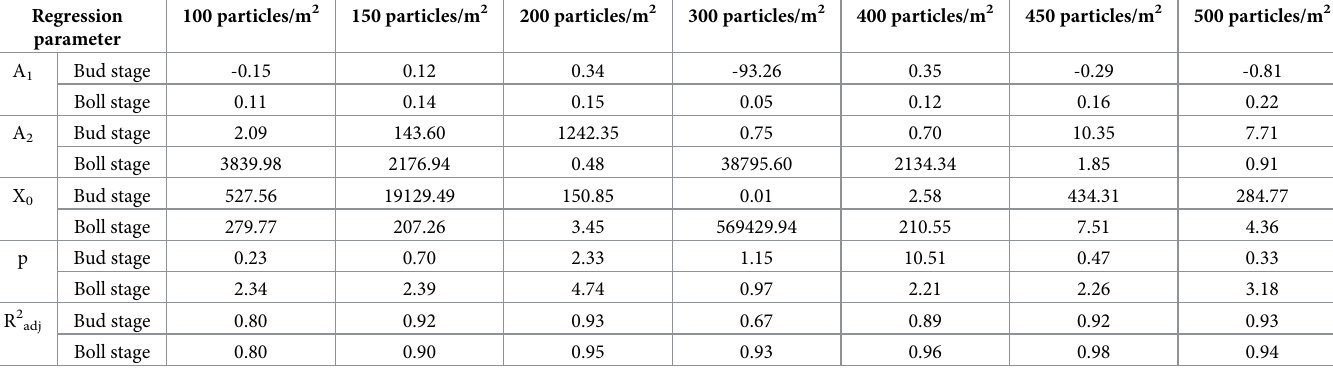
Table 4. Regression parameters of the logistic equations between the boll falling rate and hail size. Regression